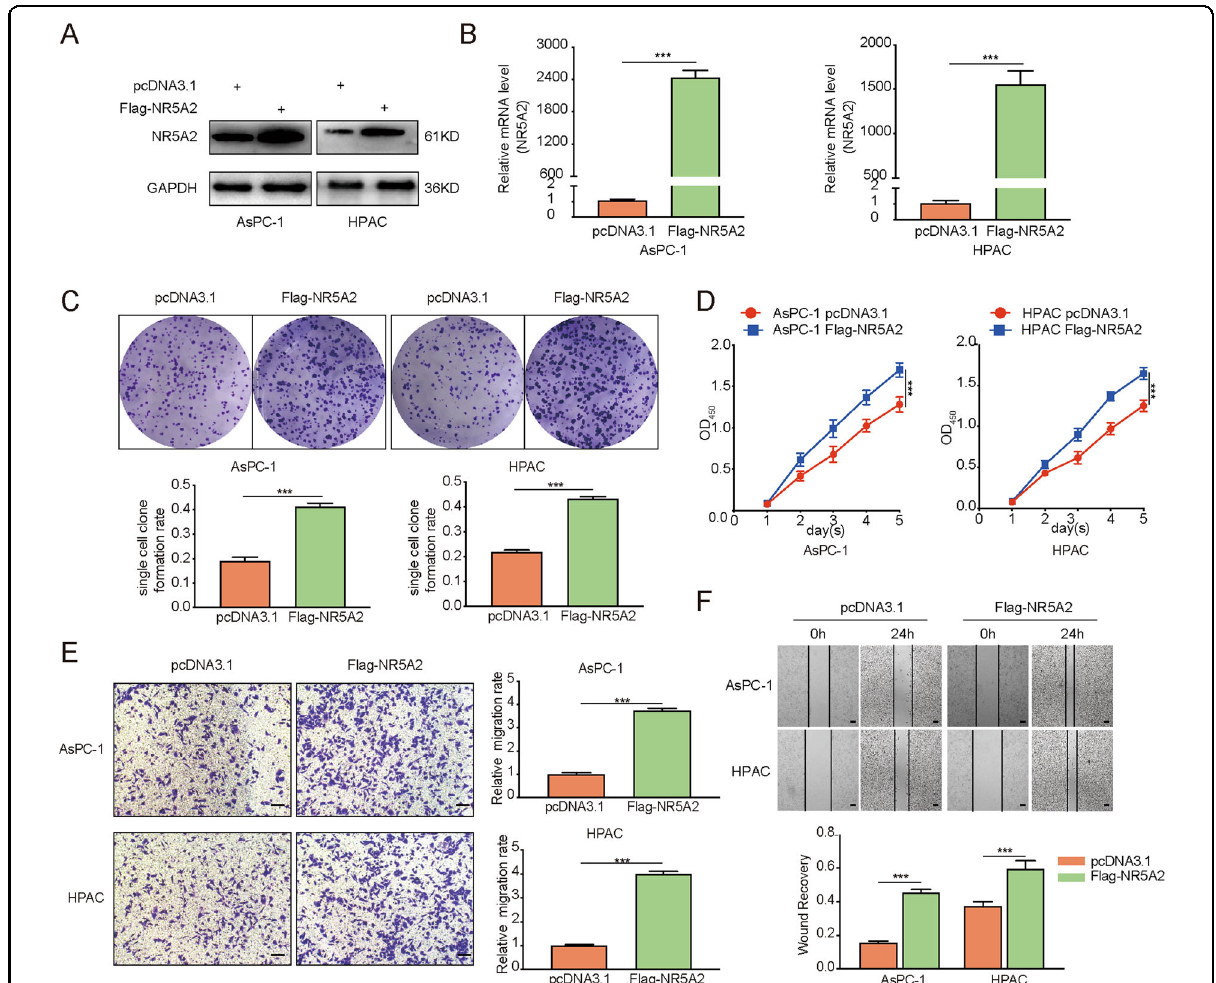
Fig. 3 Overexpressed NR5A2 promoted the potential malignancy of pancreatic cancer cells. A , B . Western blot ( A ) and RT-qPCR ( B ) analysis to show NR5A2 expression in AsPC-1 and HPAC cells infected with pcDNA3.1 or NR5A2 plasmid. GAPDH served as an internal reference. Data presented as the mean ± SD of three independent experiments. Statistical analyses were performed using an unpaired t test. C – F AsPC-1 and HPAC cells infected with pcDNA3.1 or NR5A2 plasmid were harvested for colony formation assay ( C ), MTS assay ( D , n = 5), transwell invasion assay ( E ), and wound-healing assay ( F ), scale bars: 100 μ m. Each bar represents the mean ± SD of three independent experiments. ** p < 0.01; *** p < 0.001, one- way